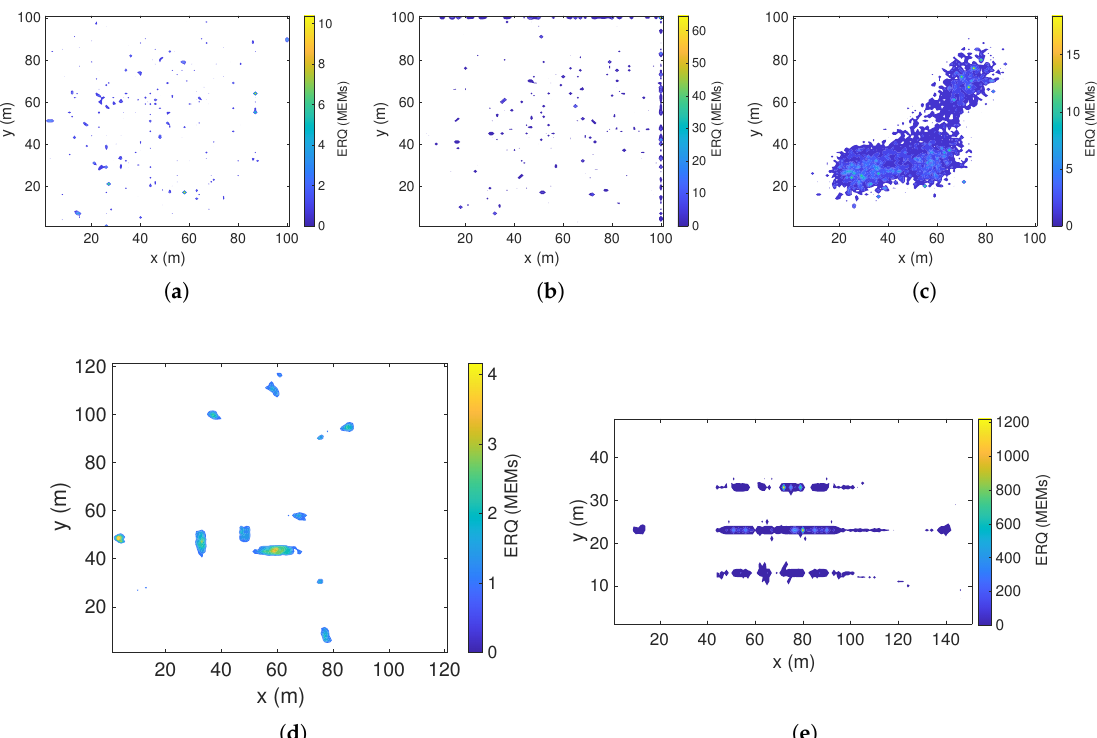
Figure 9. Heat maps of the ERQ measured in equivalent MEMs unit per cell (cell size 1 m 2 ). Higher MEMs value imply higher risks. ( a ) RWP; ( b ) SWIM: ( c ) RWPa; ( d ) Plaza; ( e )